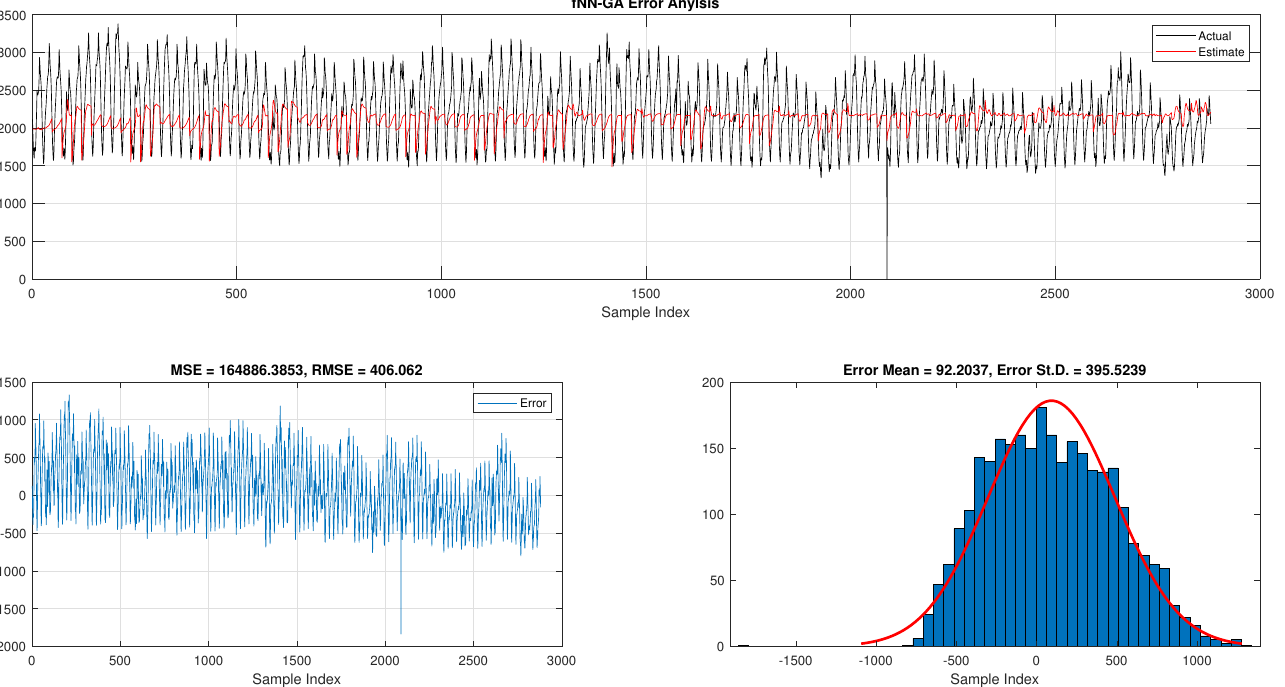
Figure 10. Error analysis of the hourly daily load consumption with fNN-GA best